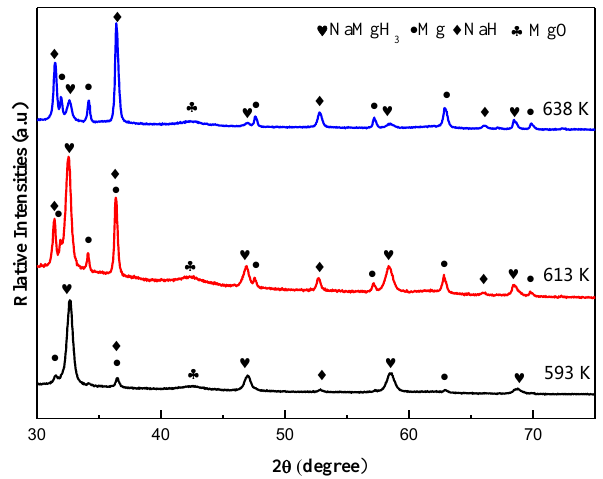
Figure 7. XRD patterns of NaMgH 3 + 2.5 G + 2.5 M hydride composite after dehydriding at different temperatures (593 K, 613 K, and 638 K).